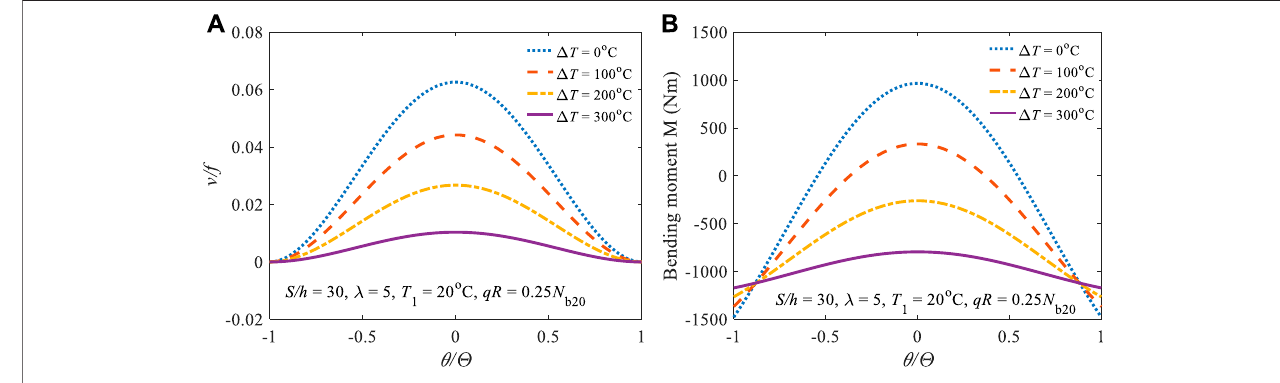
FIGURE 4 | Variations of (A) radial displacements and (B) bending moment along the arch axis.